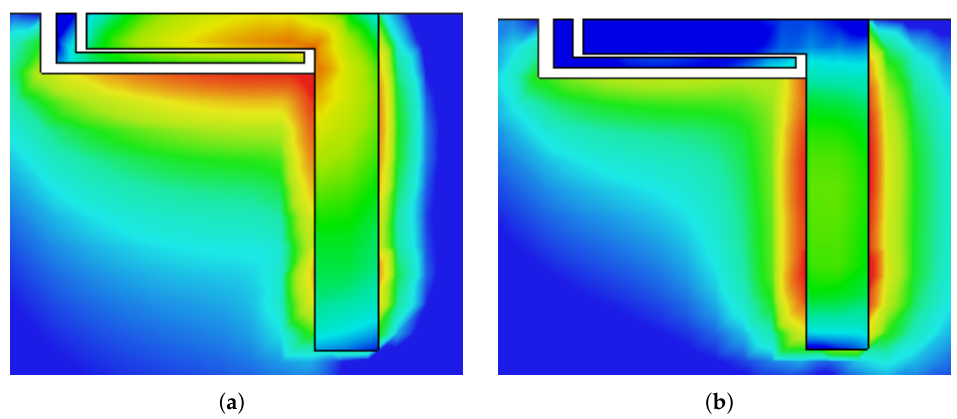
Figure 4. Surface current distribution of single antenna element at ( a ) 3.5 GHz and ( b ) 4.8 GHz.